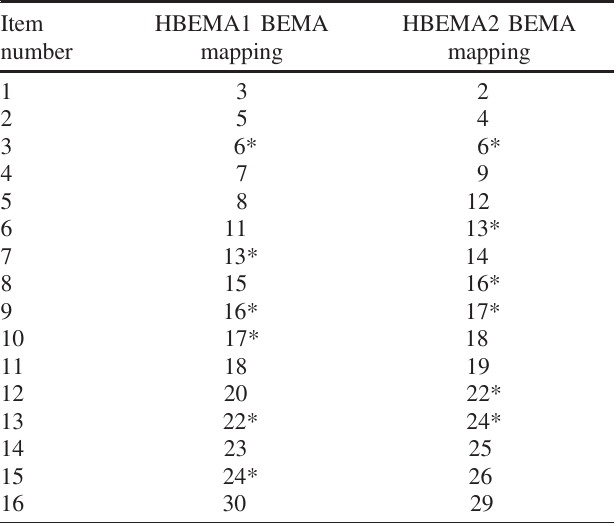
TABLE IX. BEMA to HBEMA mapping. The item order for each HBEMA is shown below, with mapped item numbers of the full-length BEMA. Items marked with asterisks (*) are common “ anchoring ” items that appear on both versions of HBEMAs at approximately the same locations in the respective